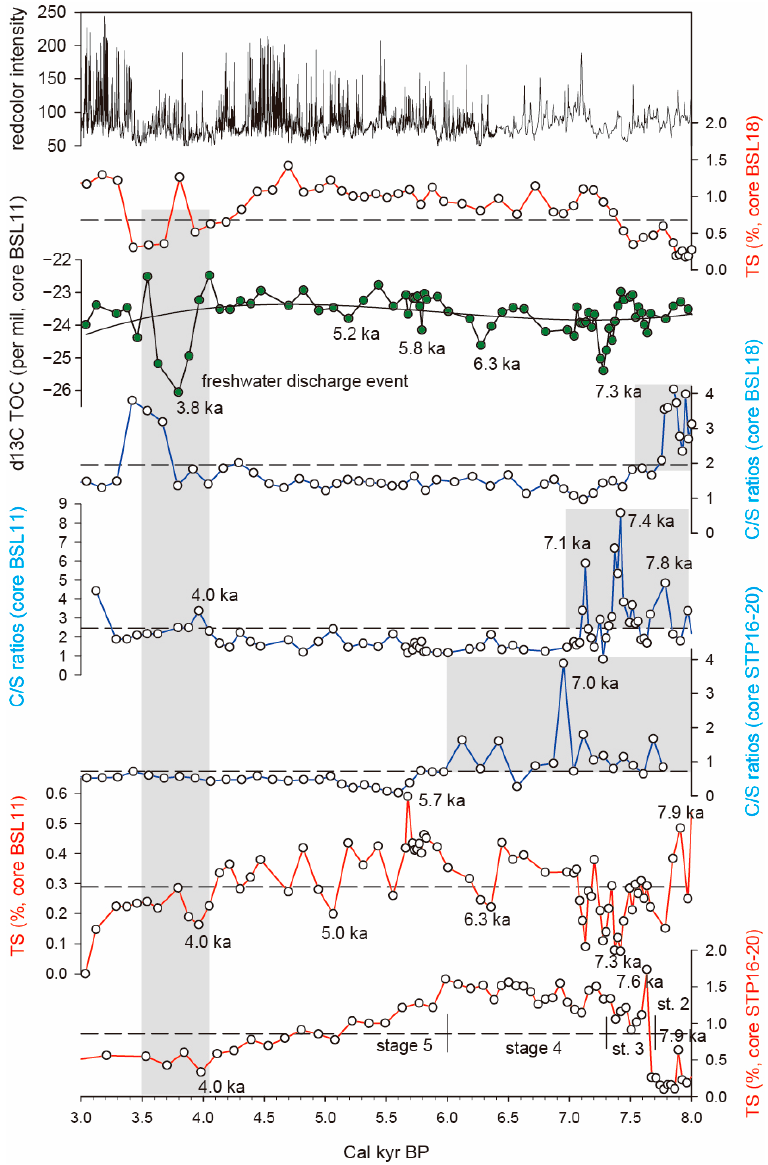
Figure 5. Comparison of sedimentary environmental proxies ( δ 13 C TOC , TS, C/S ratios, and red color intensity) from the Deukryang area with reconstructed climate change on the southwestern coast of Korea (Goheung area from core STP18-20 [11], and Beolgyo area from core BSL18 [4]).